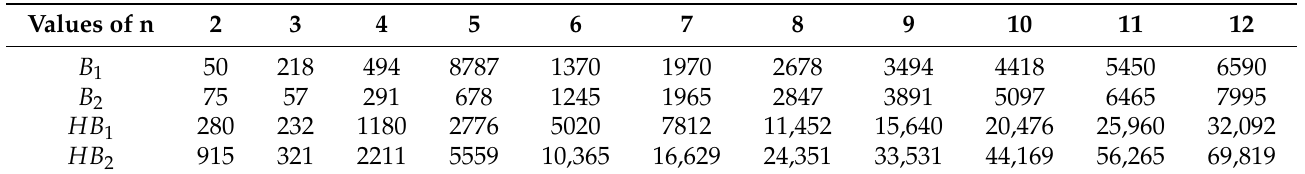
Table 4. Numerical comparison of topological indices of CNB n .